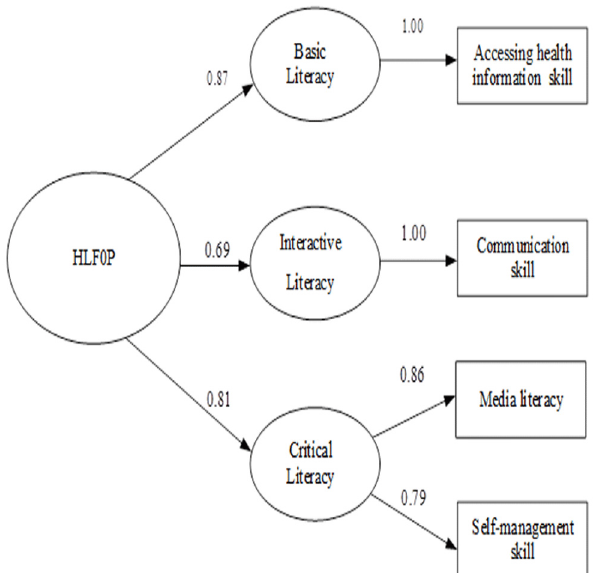
Figure 2. Confirmatory factor analysis of health literacy for obesity prevention among primary school students in Bangkok, Thailand. Chi-Square = 0.96, df = 1, P-value = 0.33, RMSEA = 0.000, SRMR = 0.0058, NFI = 1, GFI = 1 and AGFI =